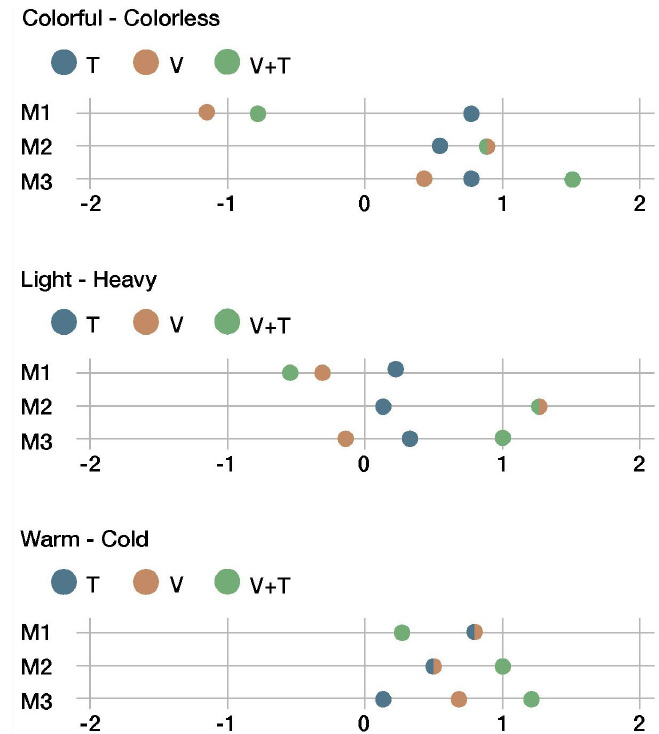
Figure 13. Second cluster of sensorial properties.